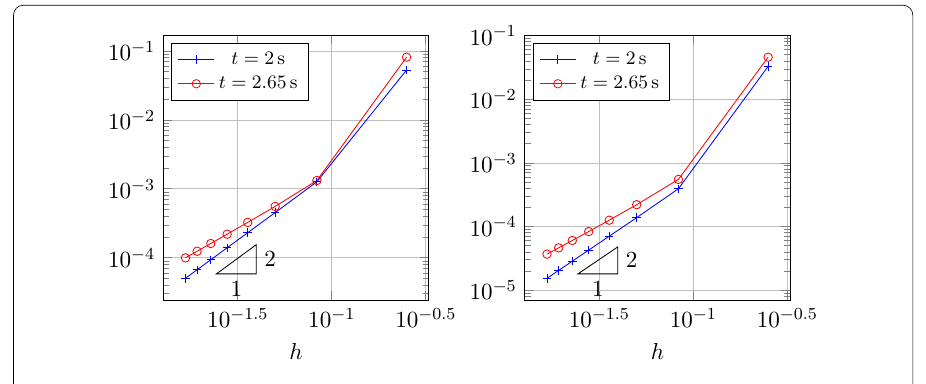
Fig. 2 Convergence of scheme (QIP) w.r.t. the space step h , for final time t = 2s, t = 2 . 65s for a